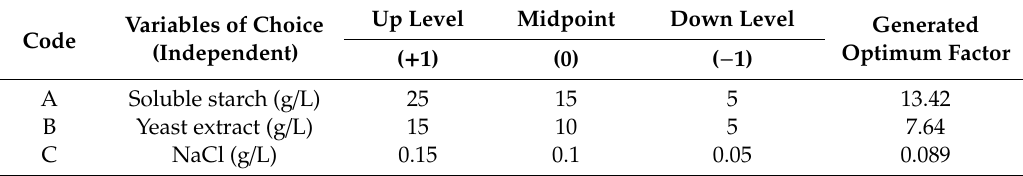
Table 1. Experimental design and independent variables of choice for optimizing culture